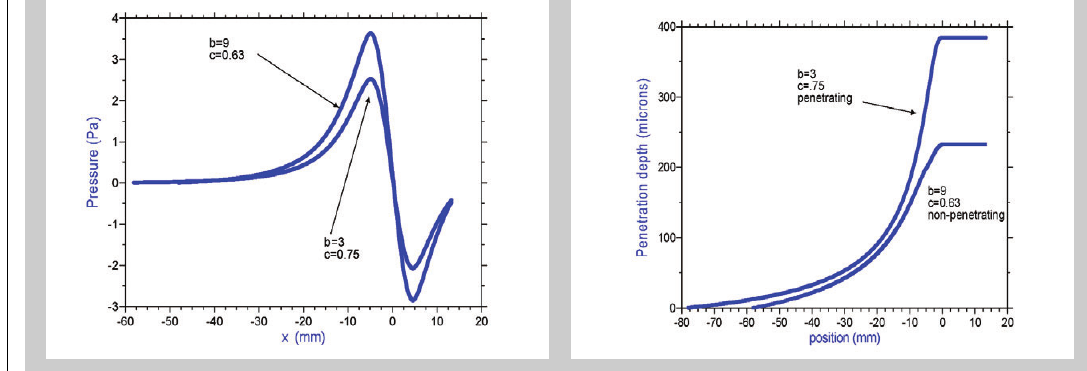
Figure 7: Pressure profiles prediction of the model for shear thin- ning parameters that repre- sent compounds 1 and